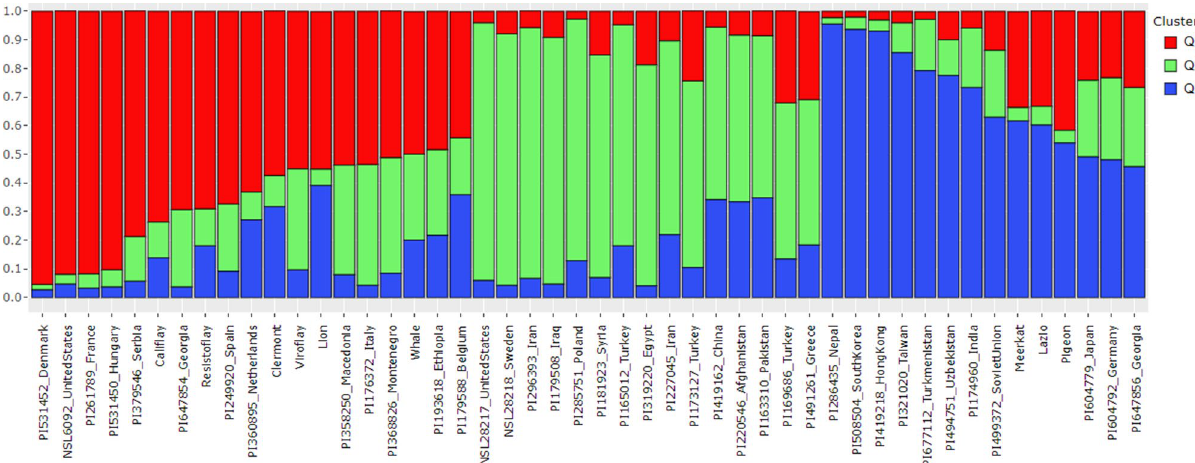
Figure 5. Population structure analysis classified 48 spinach accessions into three population groups based on delta K analysis. The distribution of spinach accessions to the three population clusters Q1, Q2, and Q3 was colored red, green, and blue. The accession name and country of origin are denoted on the x-axis, while the y-axis represents the membership proportion of accession to different population